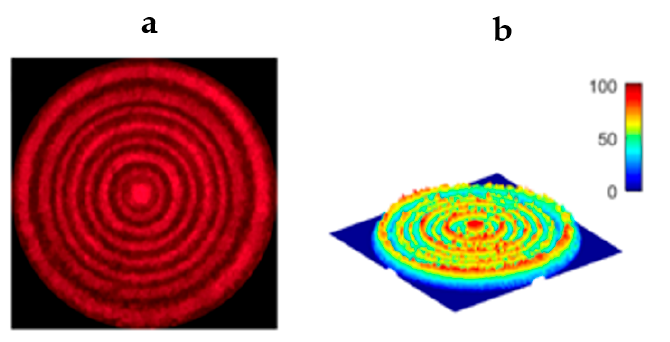
Figure 14. Observation of diffraction rings provided by FLC CDG: ( a ) the far-field diffraction patterns and ( b ) visualization of light intensity profiles [71].